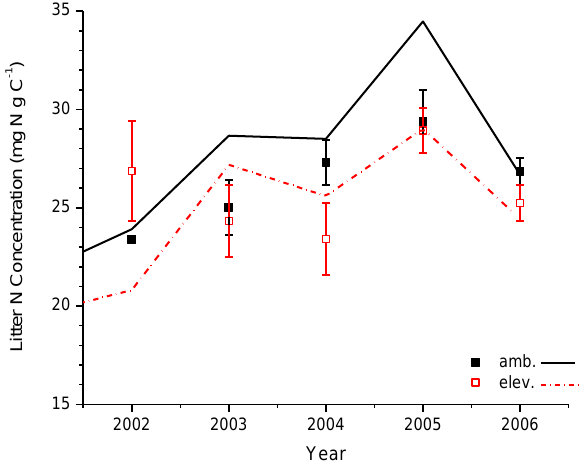
Fig. 12. Litter N concentrations measured (symbols) and Fig. 12 modelled (lines) ambient ( ∼ 374µmolmol − 1 ) vs. elevated ( ∼ 541µmolmol − 1 ) C a at the Rhinelander FACE experiment. Measured data from Talhelm et al. (2012), with error bars representing standard errors from replicated measurements ( n =